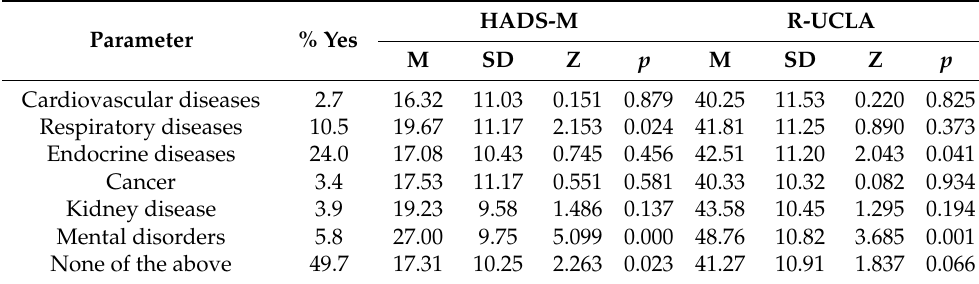
Table 6. Presence of chronic diseases regarding HADS-M and R-UCLA scores.